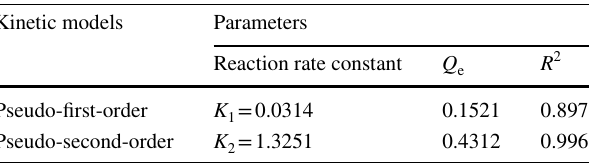
Table 2 Kinetic parameters for the adsorption of MO onto